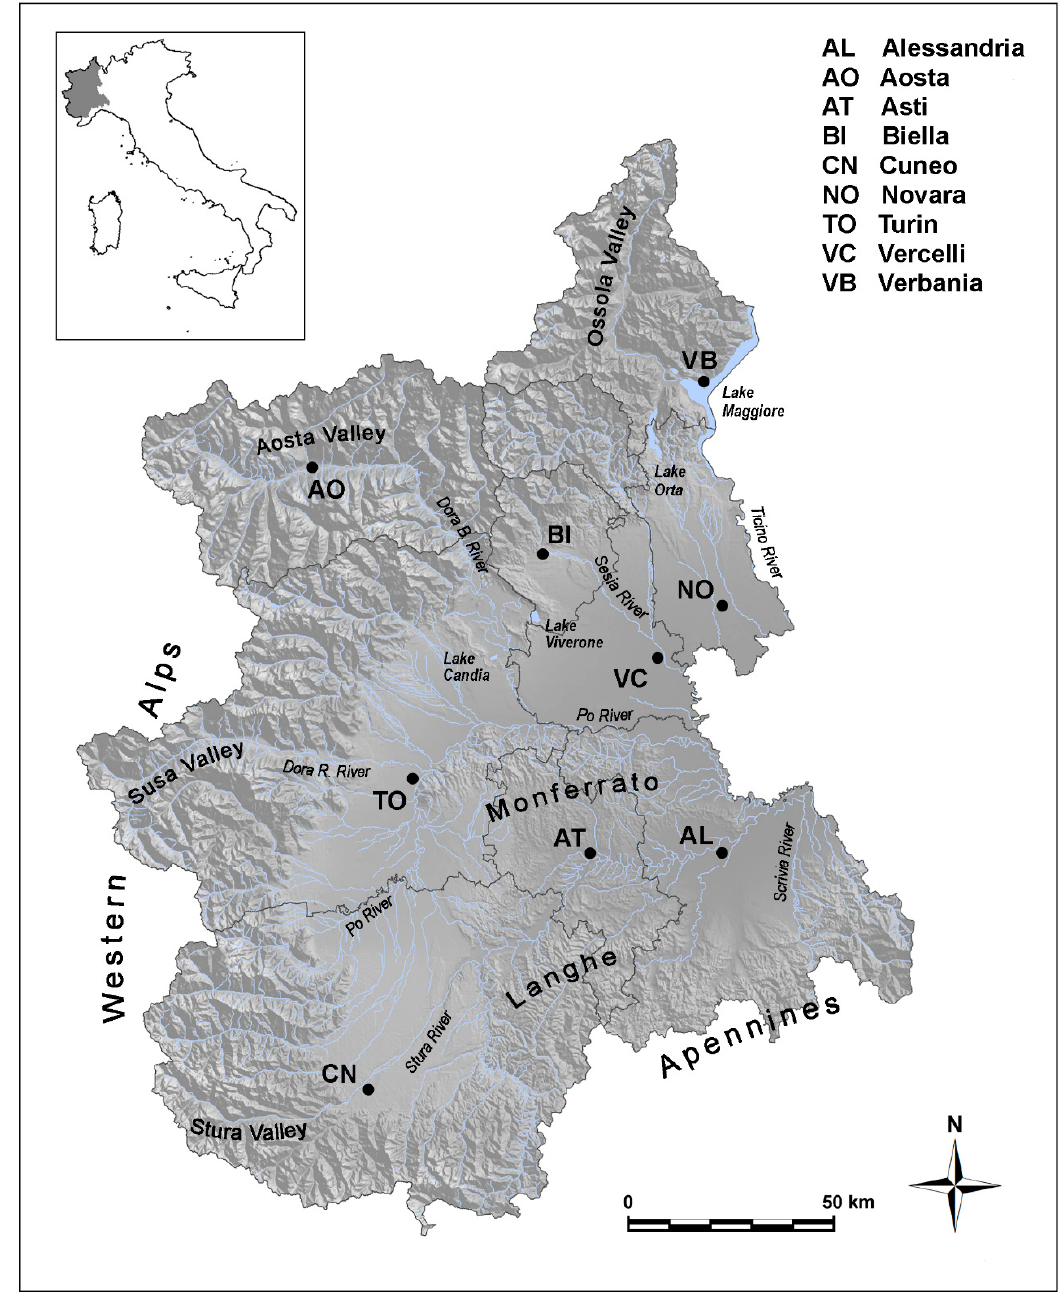
Figure 1. Map of northwestern Italy (Piedmont and Aosta Valley, PAV). The nine provinces (the capital cities and administrative areas) are indicated on the map; the most important geographical sectors, lakes, and rivers are also indicated.